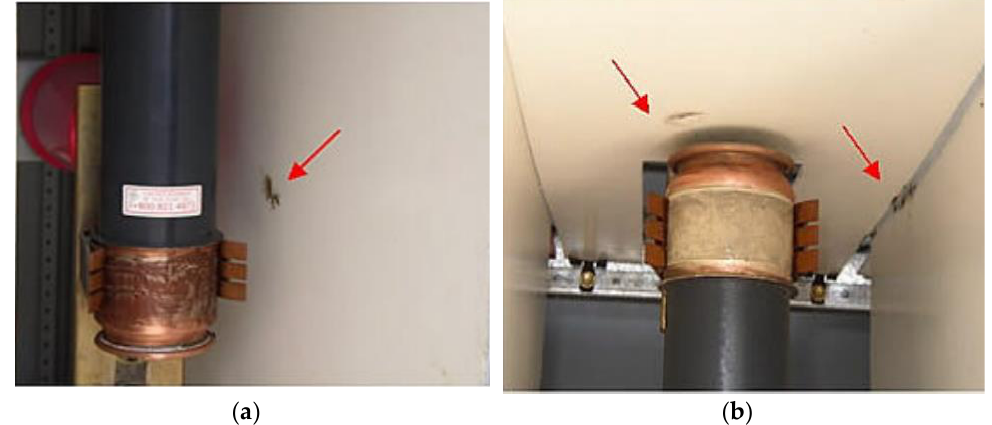
Figure 11. ( a , b ) show between a-phase and b-phase fuses; carbon trails may be seen on the insula- tion [36].